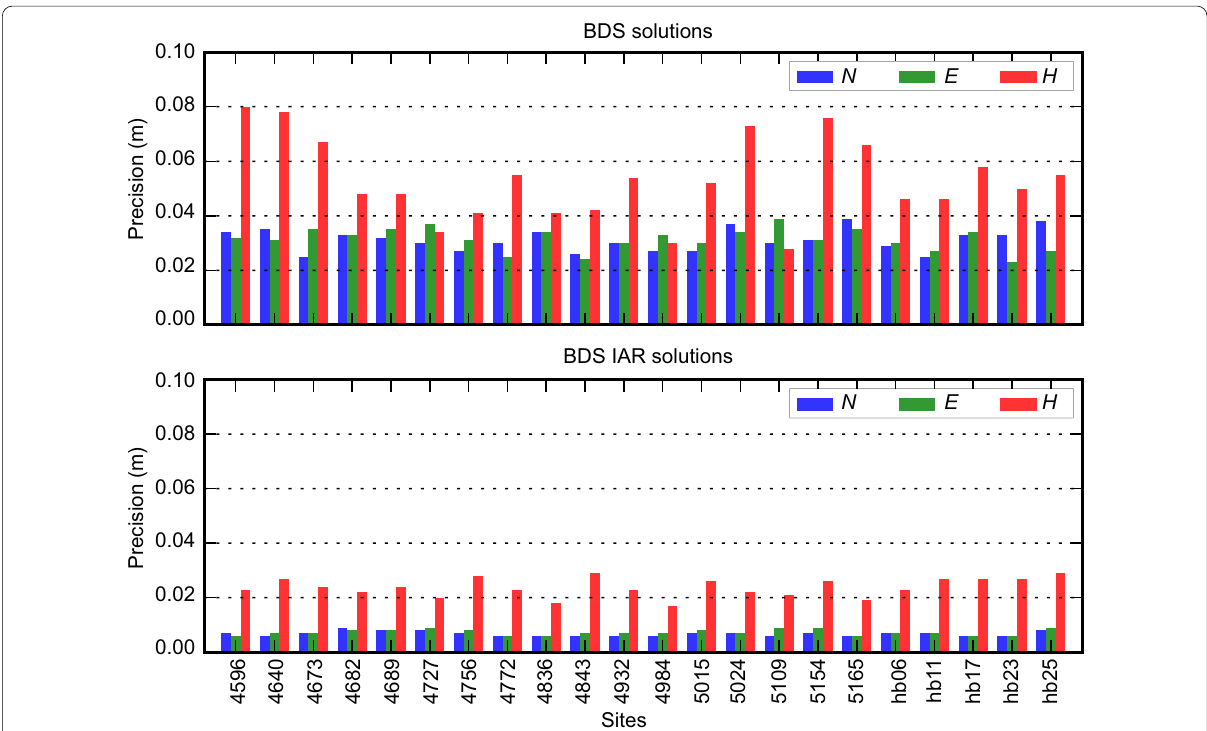
Fig. 7 BeiDou only PPP (top) and PPP-IAR (bottom) solutions for North (blue), East (green) and Height (red)